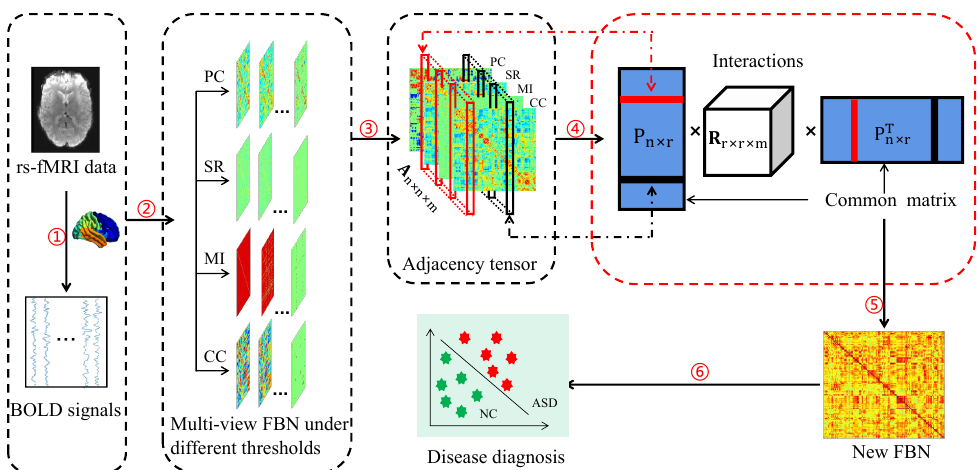
Figure 1. Illustration of the proposed multiview functional brain network fusion method, includ- ing six major parts: (1) rs-fMRI preprocessing; (2) estimation of initial functional brain networks (FBNs) based on four strategies, i.e., Pearson’s correlation (PC), sparse representation (SR), mu- tual information (MI), and correlation’s correlation (CC); (3) selection of the initial FBNs under the optimal parameter; (4) factorization of the tensor stacked by the selected FBNs to obtain the common matrix ( P ) of different FBNs; (5) construction of a new FBN based on P for each subject; and (6) disease